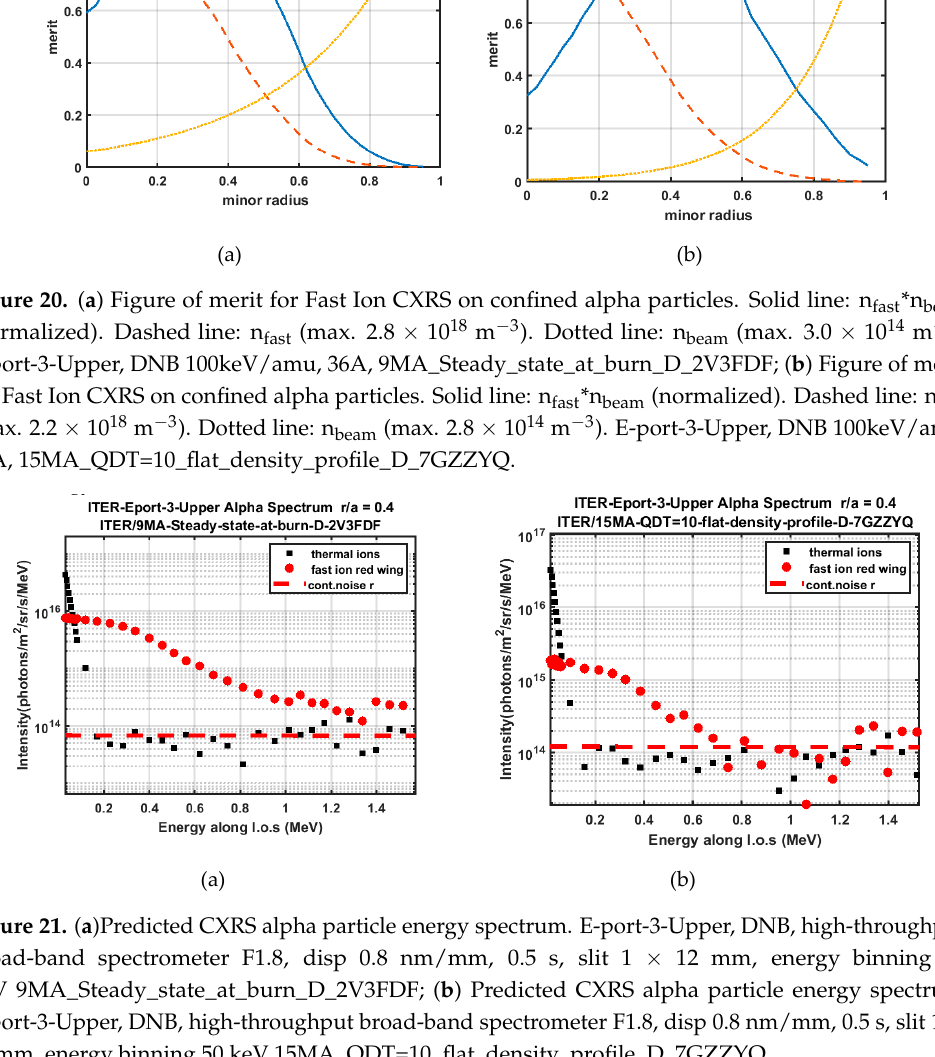
Figure 21. ( a )Predicted CXRS alpha particle energy spectrum. E-port-3-Upper, DNB, high-throughput broad-band spectrometer F1.8, disp 0.8 nm/mm, 0.5 s, slit 1 × 12 mm, energy binning 50 keV